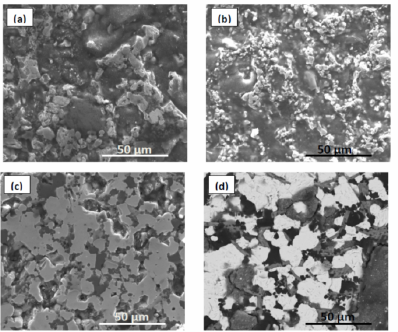
Fig. 5 SEM images of (a) 2M1, (b) 2M2, (c) 2M3, and (d) BSE image of 2M4 composites PLRS at 1680 ℃ .